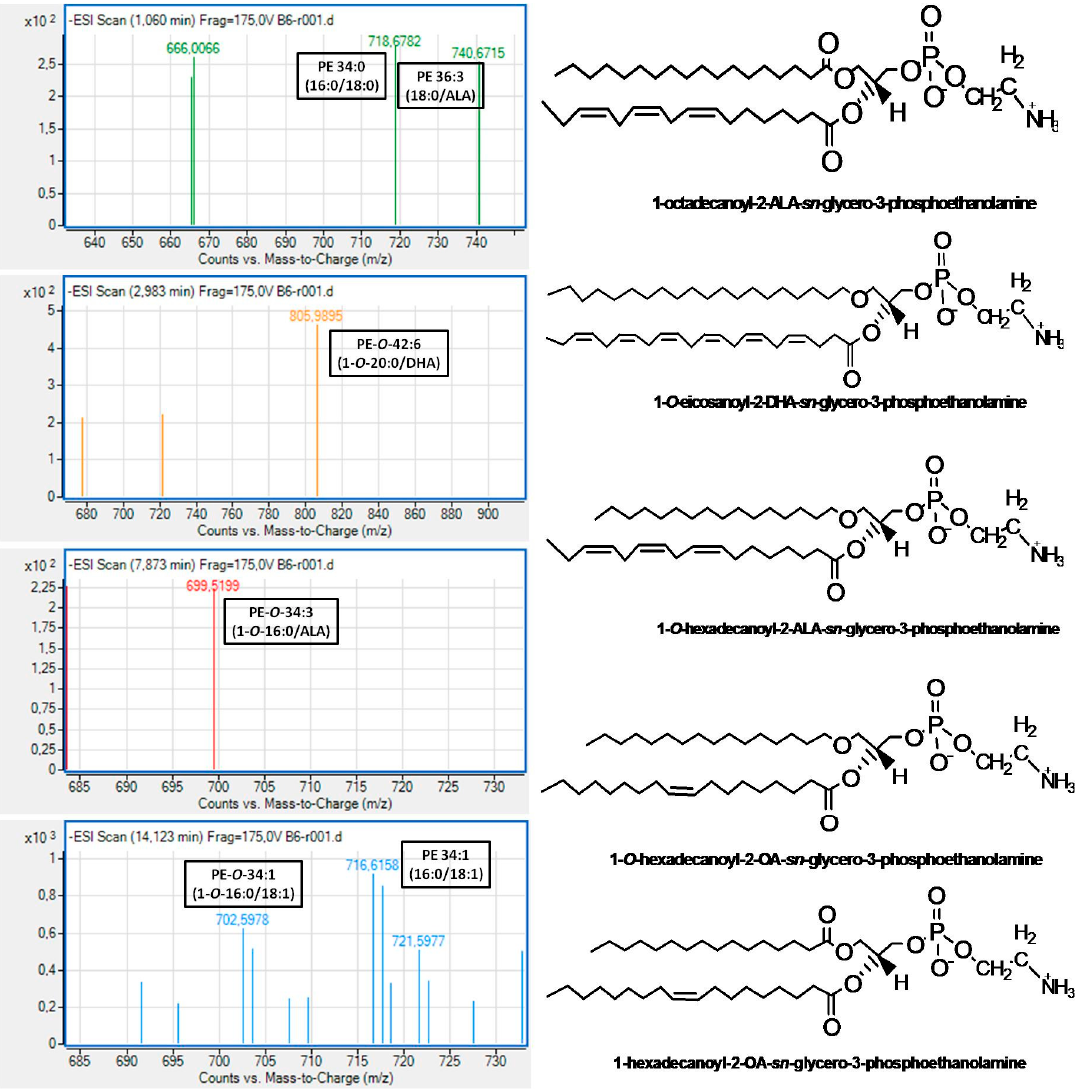
Figure 3. Representative mass spectra and structures of the bioactive PE molecules identified in the PE subclass of Irish ale. PE = Phosphatidylethanolamine; ALA = α -linolenic acid (18:3 n-3); DHA = docosahexaenoic acid (22:6 n-3); and OA = oleic acid.